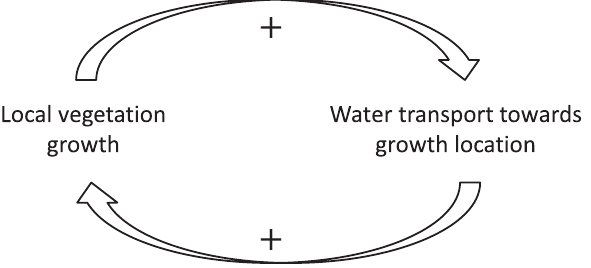
Figure 2. A general positive feedback loop that drives the formation of vegetation patterns in drylands. The feedback concomitantly accelerates vegetation growth in patches of denser vegetation and inhibits the growth in adjacent sparser patches. The combined processes favor the growth of nonuniform perturbations and the formation of vegetation patterns. From